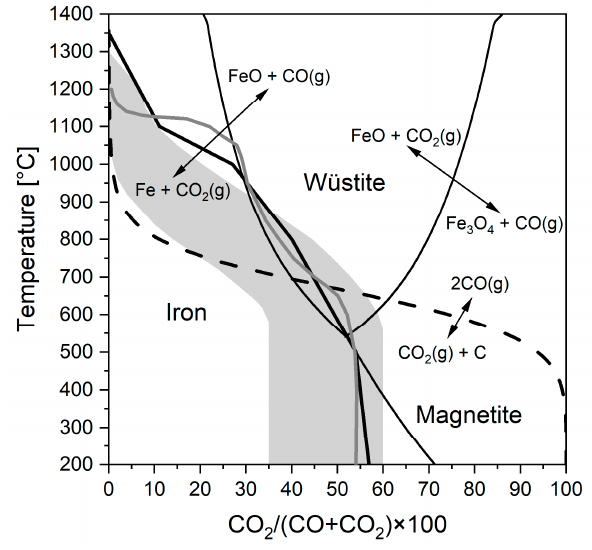
Figure 4. Reducing conditions in the reduction-softening test marked with a black-coloured bold line in an Fe-O-C phase-stability diagram. The grey area shows the typical blast furnace conditions, and the grey curve depicts the conditions in a European blast furnace, measured with descending probes.